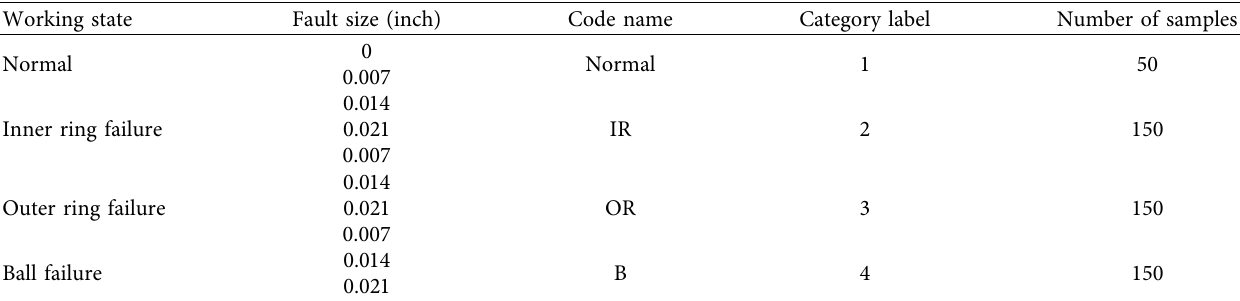
Figure 2: Flowchart of the proposed fault diagnosis method. Table 1: Working states and